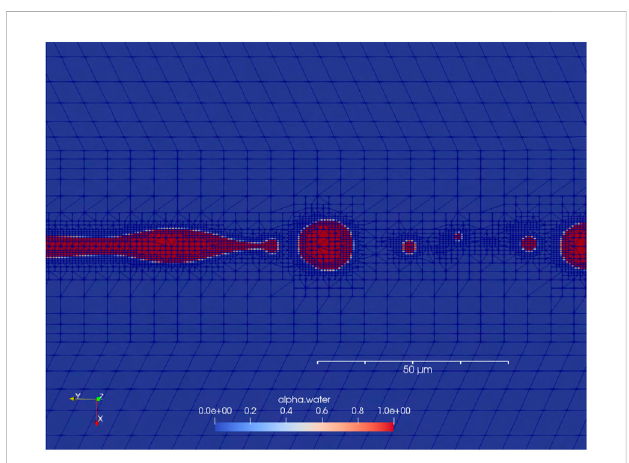
FIGURE 21 Visualization of the Plateau – Rayleigh instability of the microjet ascertained from simulation data. The simulation shows the dynamic computational grid with three AMR levels for the cells in the vicinity of the liquid – gas interface for the bell-shaped nozzle design.